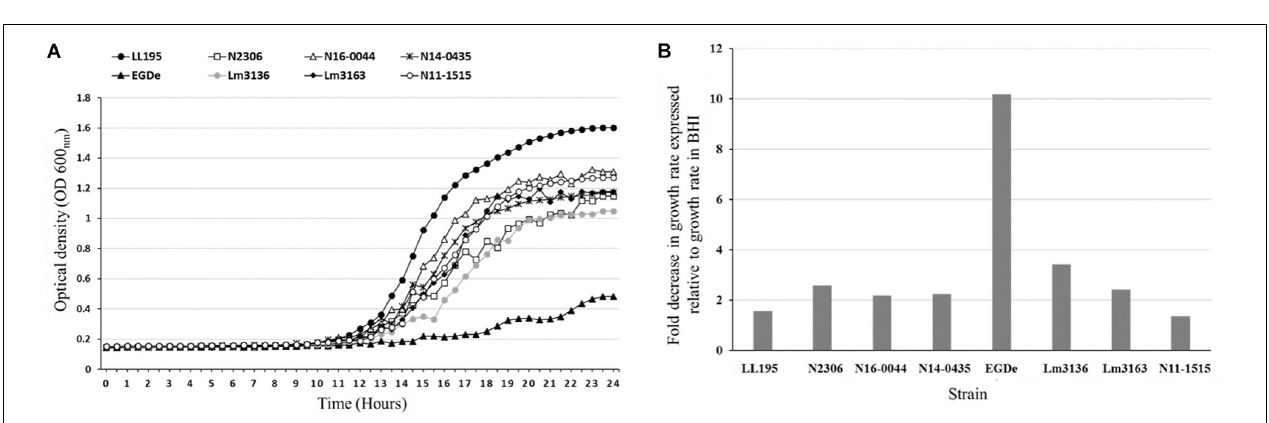
FIGURE 3 | Heatmaps showing clustering of the strains based on PM01, PM02, PM09, and PM10 growth/metabolic activity results. Clinical listeriosis outbreak strains are shown in red, strains isolated from food during routine check are shown in blue and the L. monocytogenes EGDe reference strain is shown in black. Each of the colored bars identified on the x -axis represents the different PM test conditions applied and for detailed information on the reactions see Supplementary Figures S2A–D .